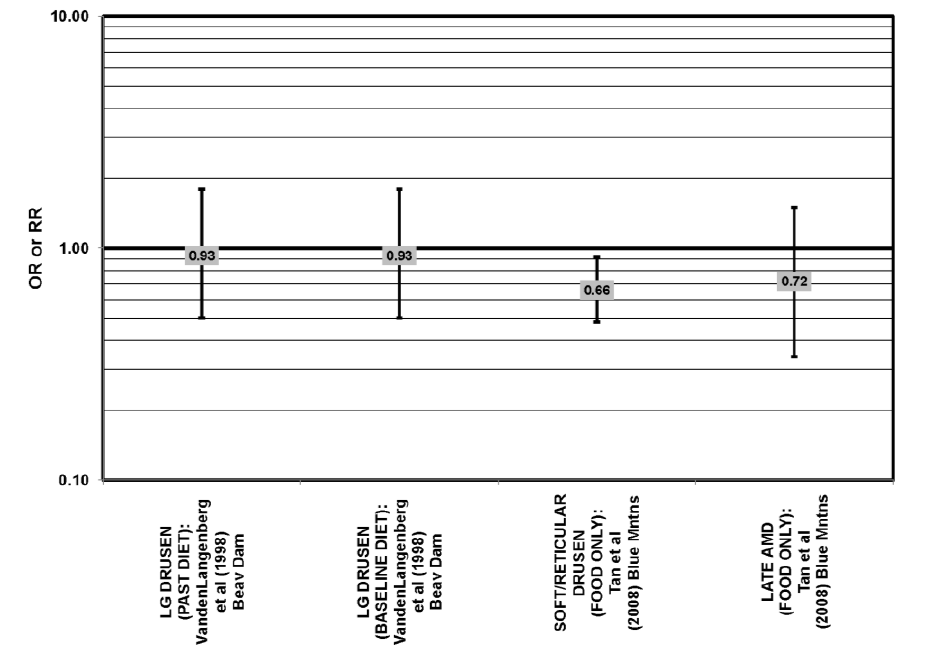
Figure 31. Late AMD odds or risk ratio; high vs. low intake of lutein and zeaxanthin: prospective